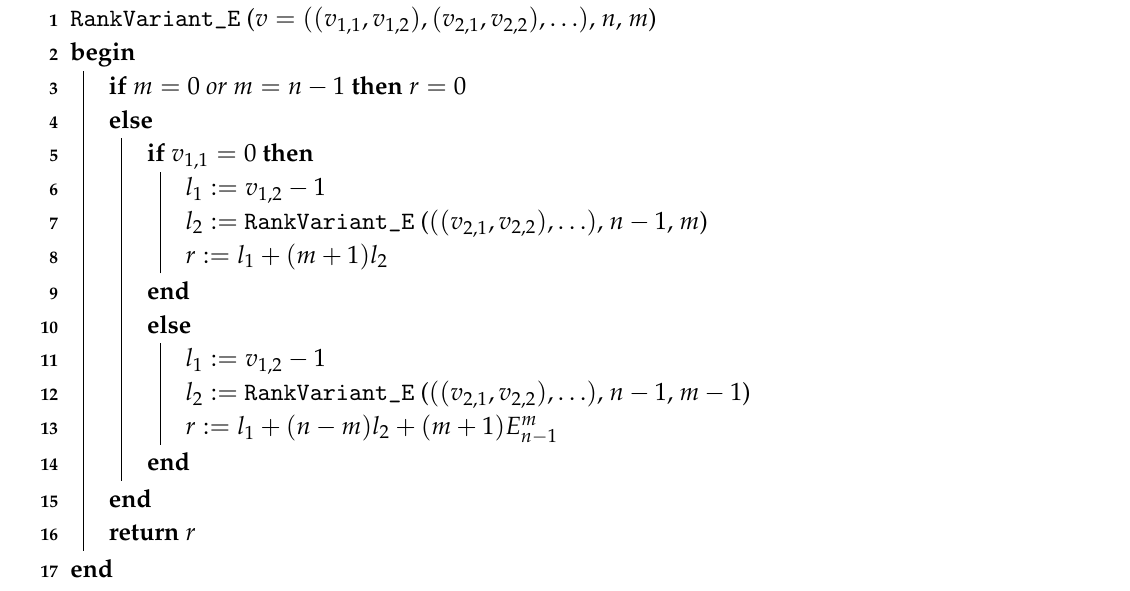
Algorithm 7: An algorithm for ranking the variants of the AND/OR tree for E m